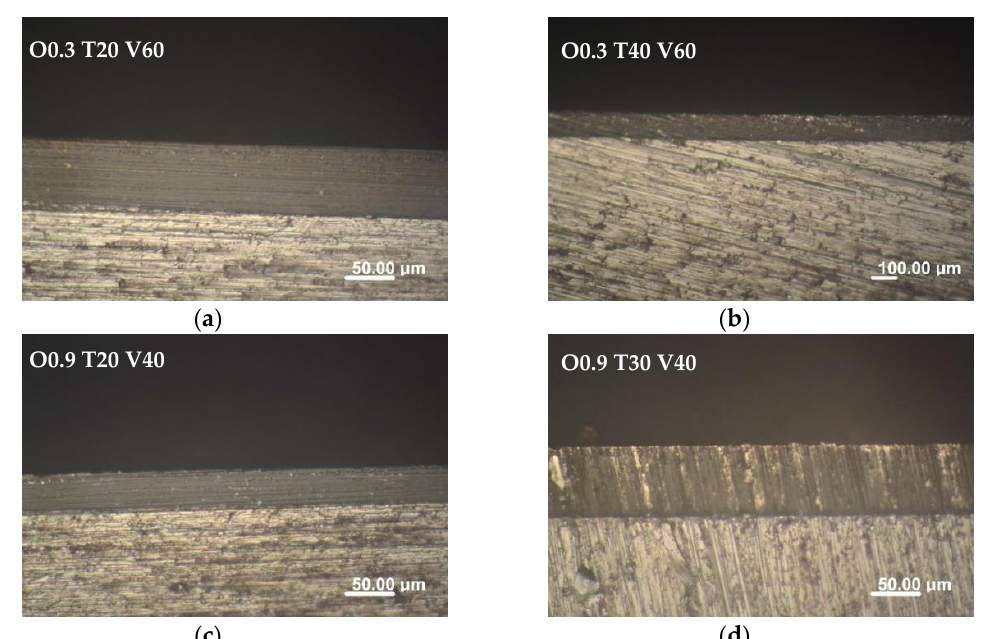
Figure A2. Optical micrograph of the cross-section of AAO film obtained by means of a one-step anodization process of 1 h in 0.3 and 0.9 M oxalic acid at different temperatures and voltages.